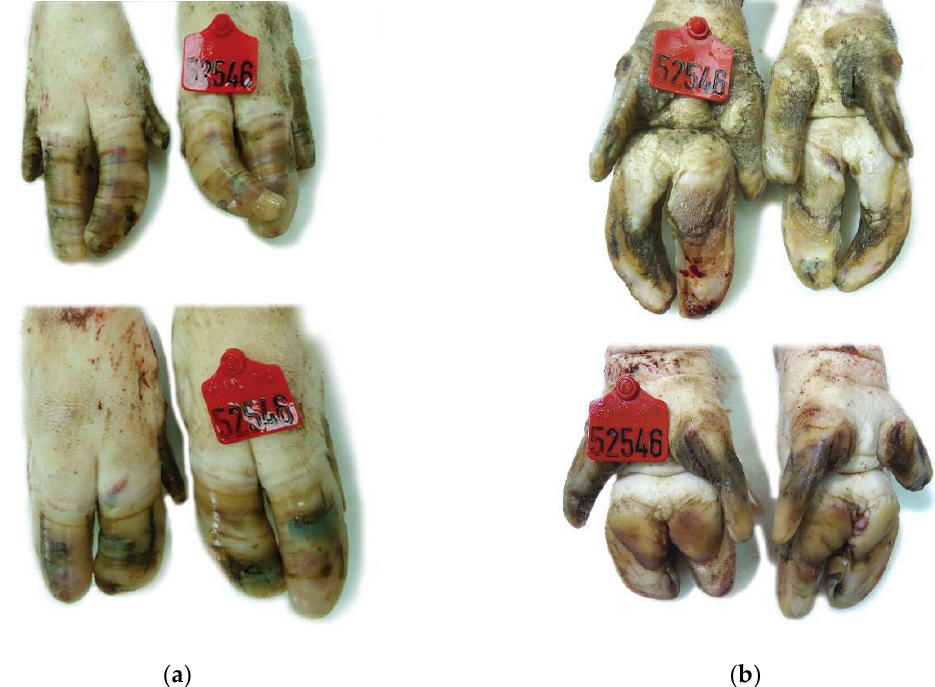
Figure 4. Claw lesions from a culled sow of genetic line A (PIC): ( a ) Dorsal view: Mildly overgrown claws. Multiple cracks, cavitating lesions and irregularity of the keratin are observed on the hoof wall ( b ) Ventral view: Cavitation and ulceration of the sole.